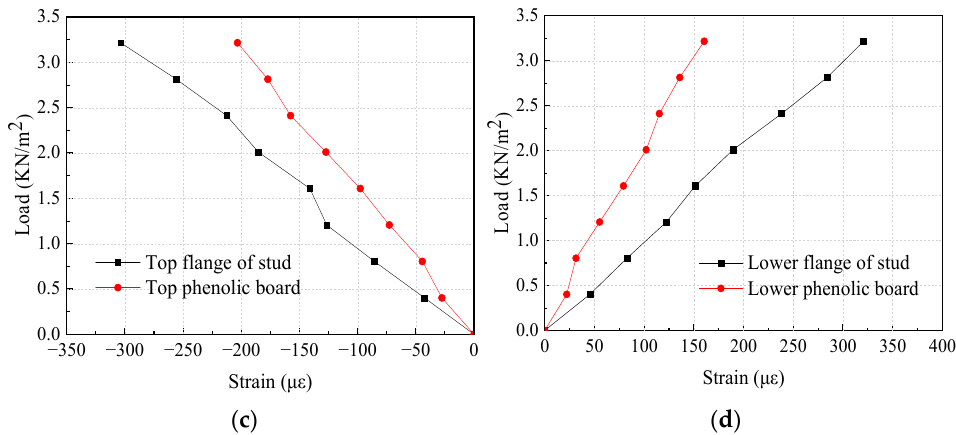
Figure 16. Strain load curves. ( a ) Strain of top flanges of light-gauge steel studs and top phenolic board of QB1-I-L-2.5-5-1; ( b ) Strain of lower flanges of light-gauge steel studs and lower phenolic board of QB1-I-L-2.5-5-1; ( c ) Strain of top flanges of light-gauge steel studs and top phenolic board of QB5-II-L-2.5-3-1; ( d ) Strain of lower flanges of light-gauge steel studs and lower phenolic board of QB5-II-L-2.5-3-1.